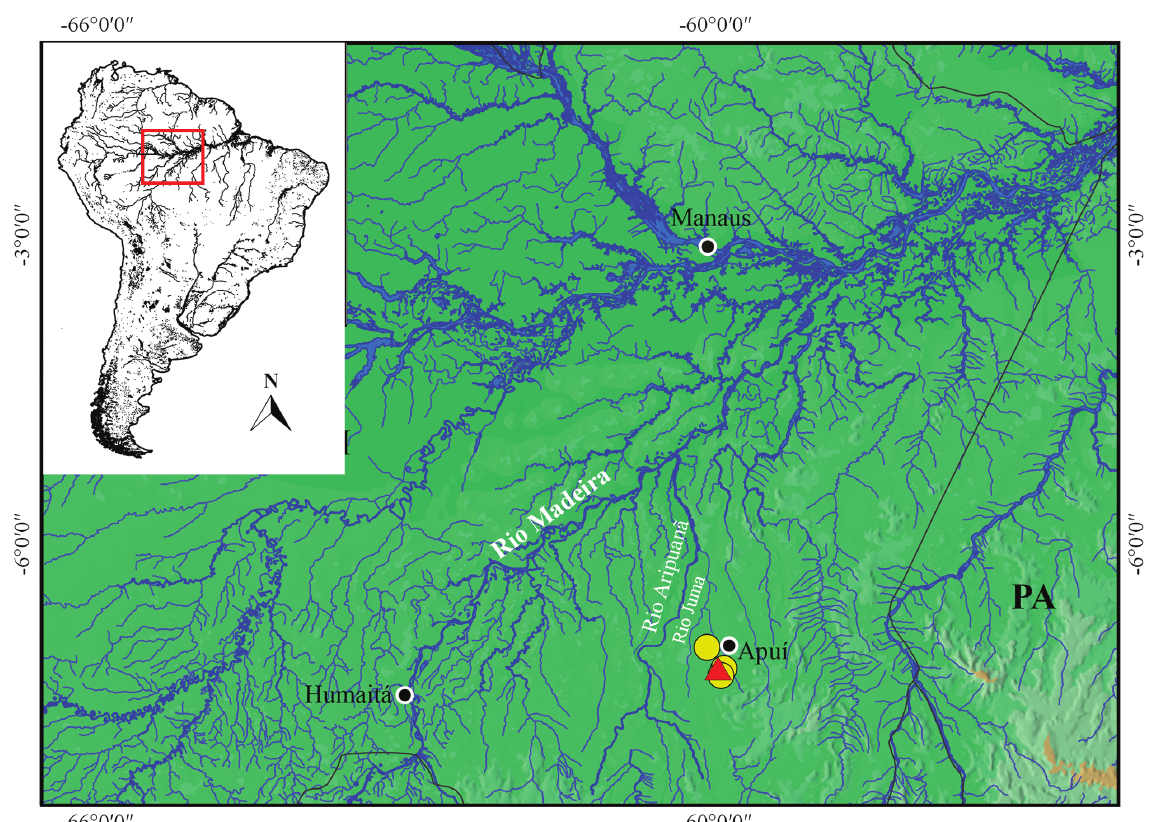
Fig. 5. Map showing the type-locality (red triangle) of Poptella actenolepis , Rio Juma, a tributary from the Rio Aripuanã, Rio Madeira basin, Brazil. Yellow circles represent